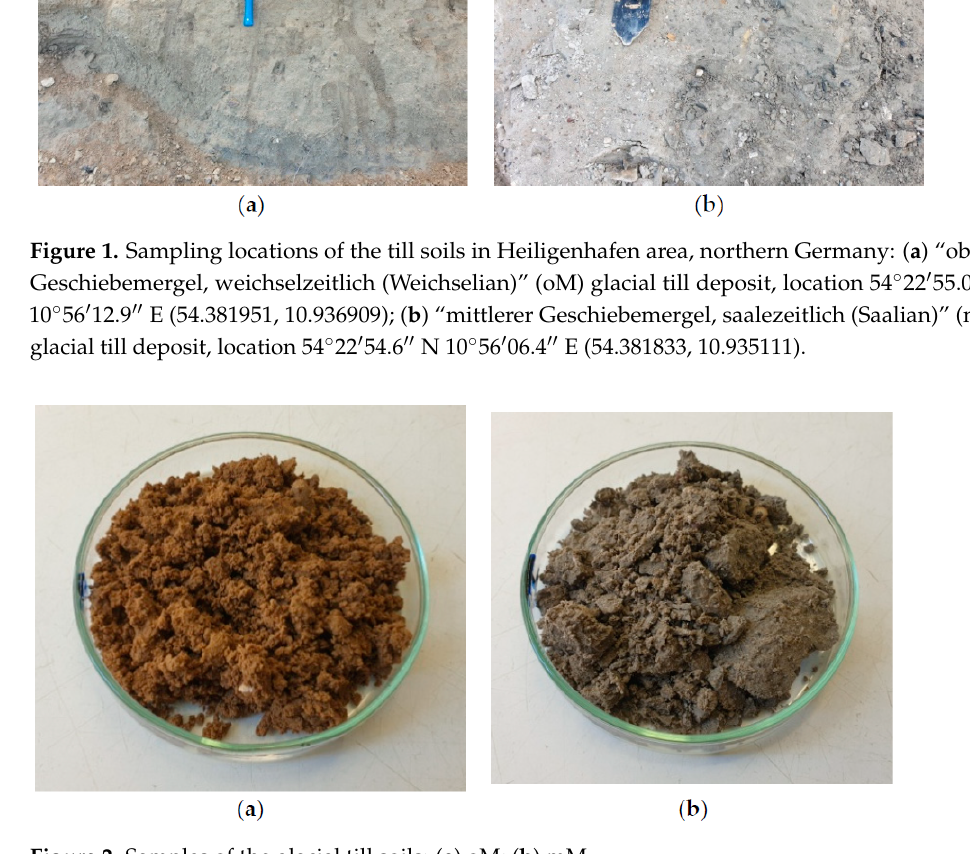
Figure 2. Samples of the glacial till soils: ( a ) oM; ( b )